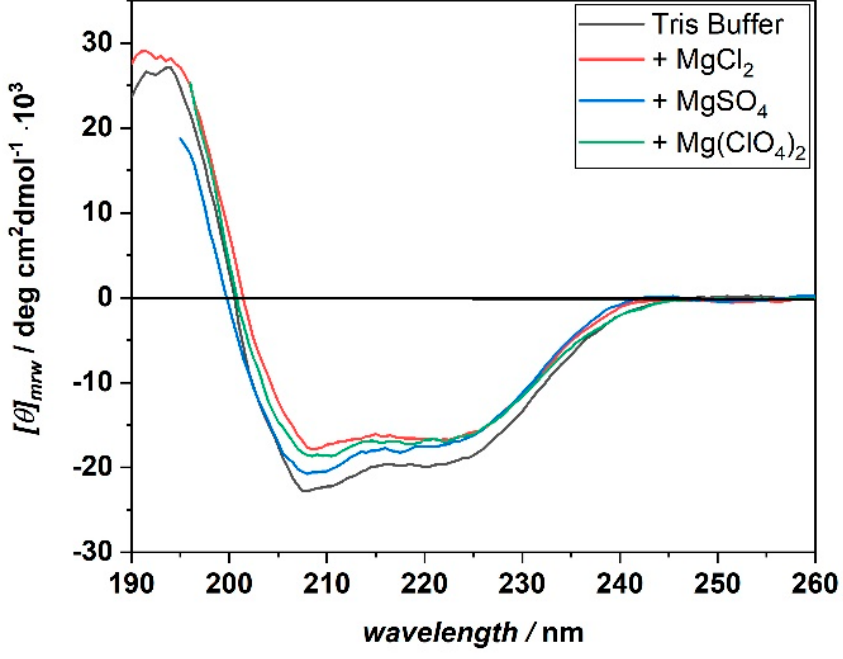
Figure 3. Far-UV CD spectra of BSA in the presence of 250 mM MgCl 2 (red spectrum), MgSO 4 (blue spectrum), and Mg(ClO 4 ) 2 (green spectrum). For reference, the CD spectrum of BSA in neat buffer condition (black spectrum) is also reported. All the spectra were acquired at the temperature of 25 ◦ C, in 10 mM Tris-HCl buffer, pH 7.4. The CD spectra are reported by plotting the molar ellipticity ([ θ ] mrw ) as a function of the wavelength, in nm.